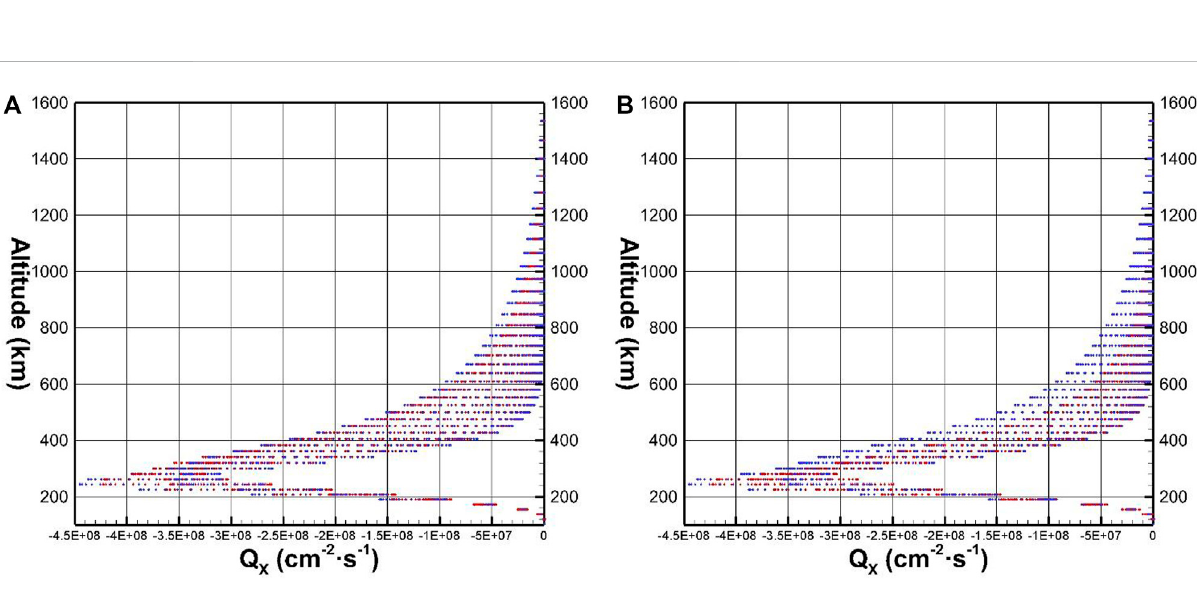
FIGURE 7 Variationsinthetailwardion fl uxescapingthroughthegridpointsinthenorthern (A) andsouthern (B) hemispherewiththealtitude.Red/Bluepoints represent the case with/without the crustal fi elds.